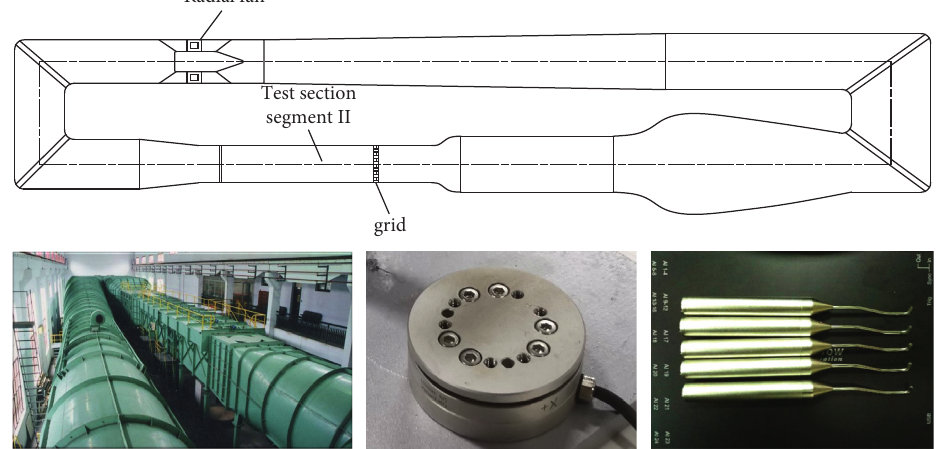
Figure 5: Wind tunnel and test